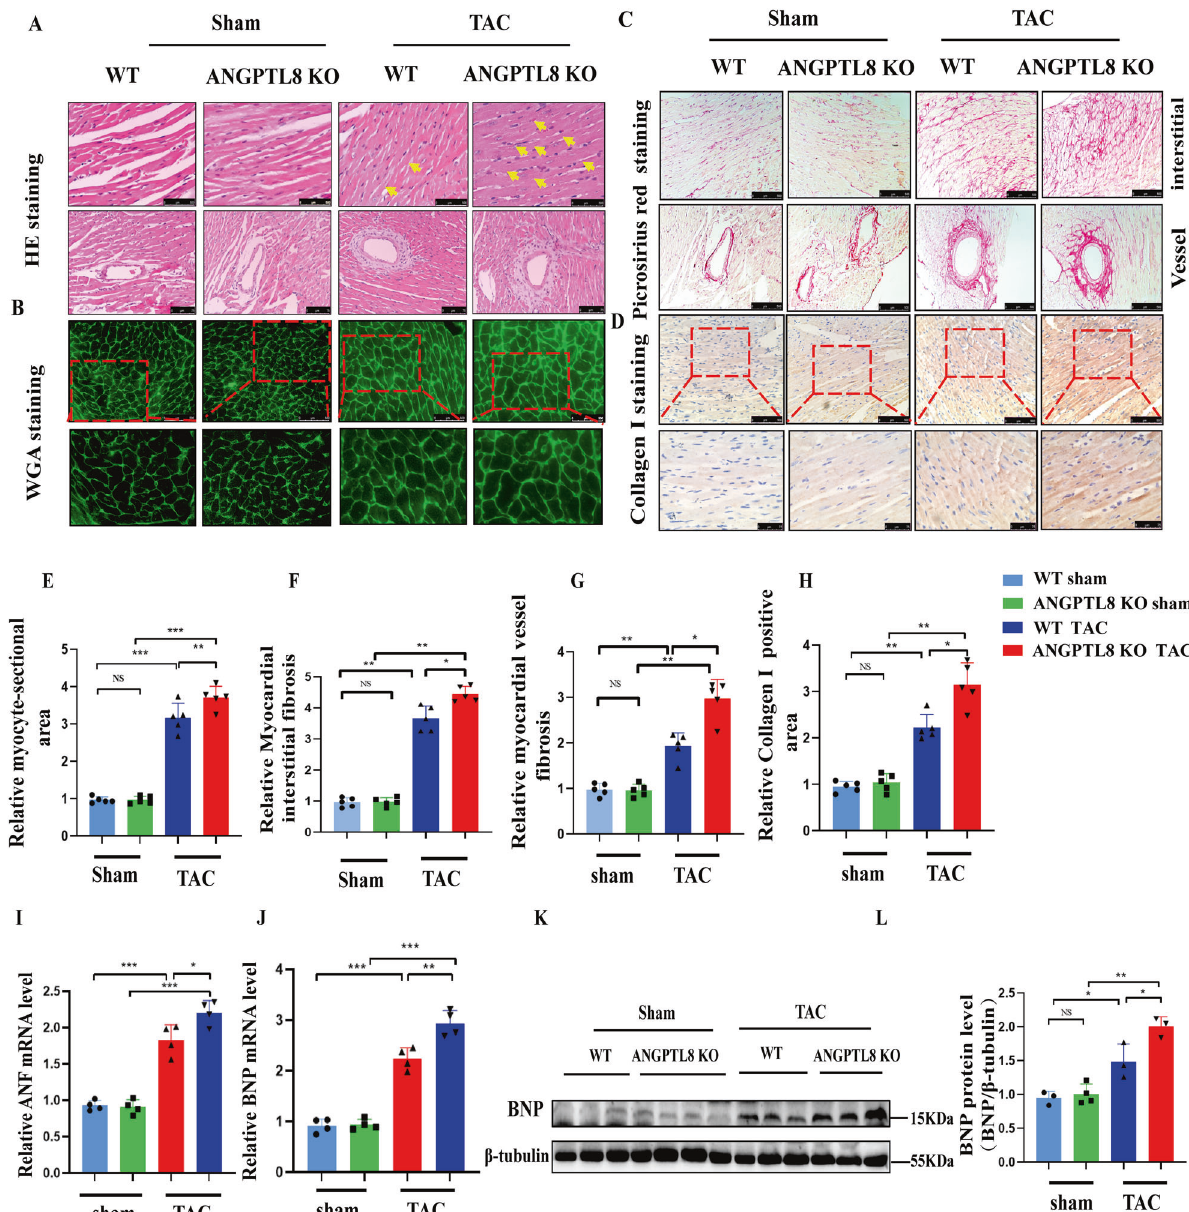
in the indicated groups (scale bar, 500 μ m and 75 μ m, respectively, n = 6 mice in each group). Quanti fi cation of the myocyte-sectional area ( E ), myocardial interstitial fi brosis ( F ), myocardial vessel fi brosis ( G ) and collagen I-positive area ( H ) of slices from WT and ANGPTL8-KO mice in the indicated groups ( n = 5 mice in each group). I , J qRT – PCR was performed to determine the mRNA levels of ANF and BNP in the indicated groups ( n = 4 mice in each group). Representative Western blots ( K ) and quanti fi cation ( L ) of the protein levels of BNP in cardiac tissue from WT and ANGPTL8-KO mice in the indicated groups ( n = 4 mice in each group), * P < 0.05, ** P < 0.01, *** P <